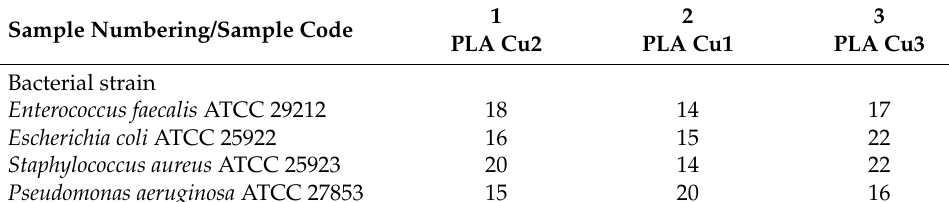
Table 8. The diameter of the bacterial inhibition zones (mm) of the tested samples.